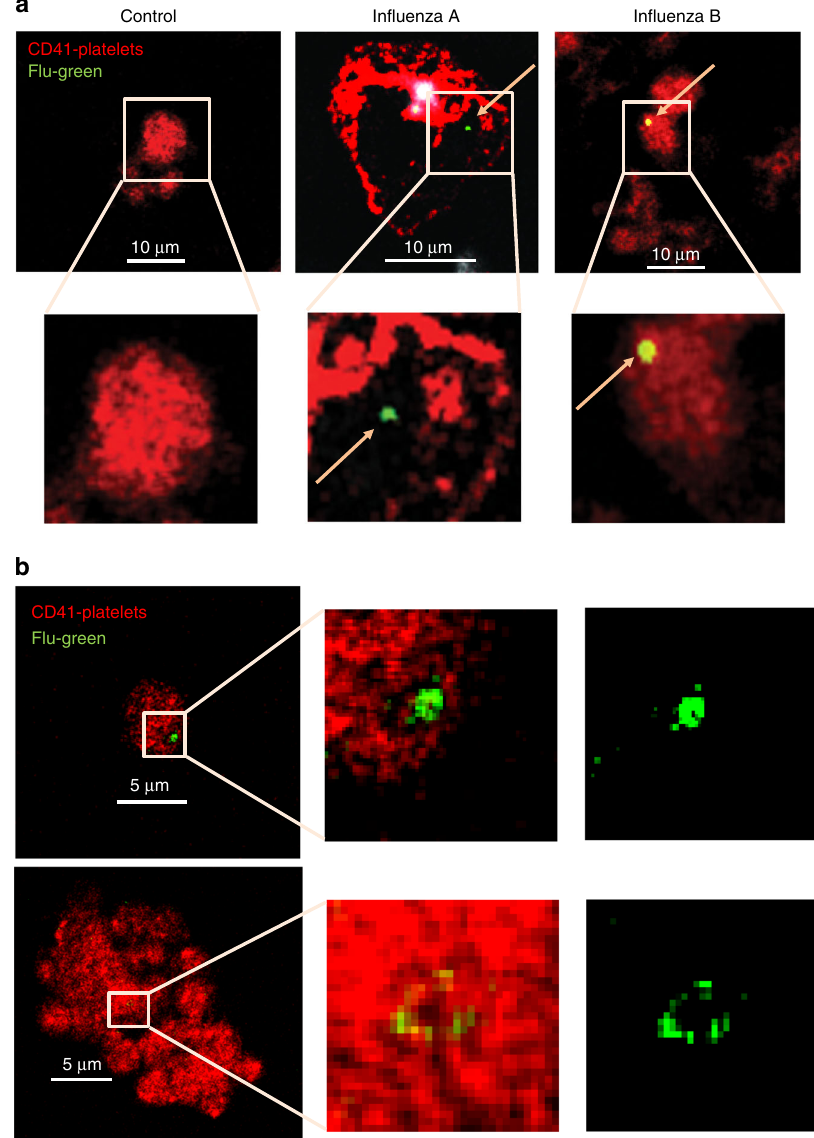
Fig. 2 In fl uenza particles are found in platelets by confocal microscopy. 50 μ L of intravenous blood drawn from a in fl uenza positive patients or healthy donors. Blood was fi xed (RBCs were lysed) and samples were later stained with antibodies for the nuclear protein for in fl uenza A (green) or in fl uenza B (green, yellow = green and red combined), for platelets stained with CD41-APC (red), and DNA from neutrophils (white). Arrows point toward the in fl uenza (green) staining. Representative images are shown from n = 10 different patients. Confocal microscopy of b platelets isolated from healthy donors and incubated with WSN/33, at 1 pfu to 100 platelets, for 30 min, at 1000 rpm, 37 °C. Platelets were fi xed, permeabilized, and stained with the same antibodies as in ( a ). Representative images of n = 4 (2F, 2M) are